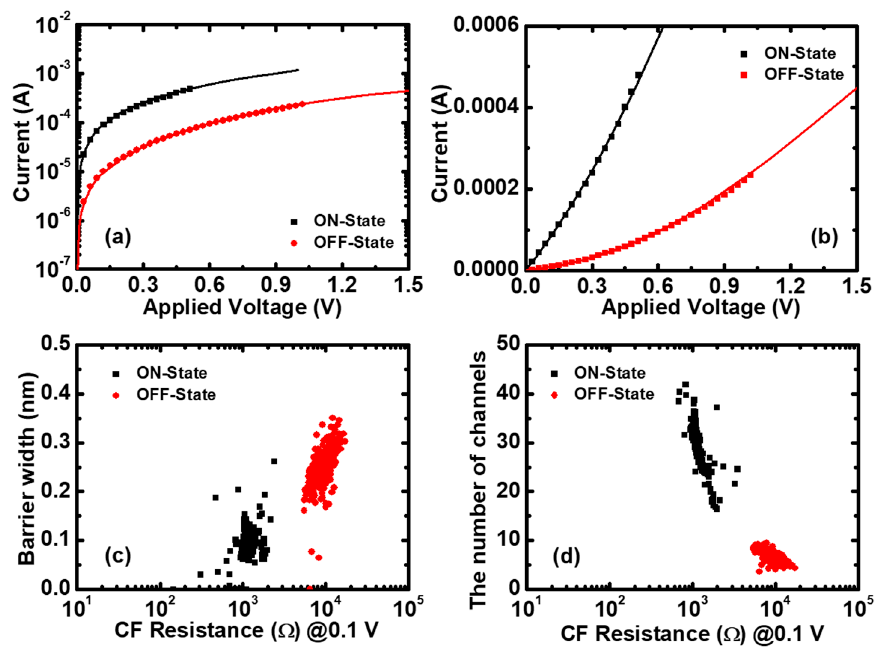
Figure 5. The quantum points contact (QPC) model applied to Pt / Pt:SiO x / Ta memristors. The I–V fitting results together with experimental data of ON and OFF states ( a ) in log scale and ( b ) linear scale. ( c ) The barrier thickness and ( d ) the number of CF paths versus the initial resistance, respectively. The averaged values are: < t gap > = 0.1 nm, < N > = 30 in the ON-state; and < t gap > = 0.25 nm, < N > = 5 in the OFF-state.